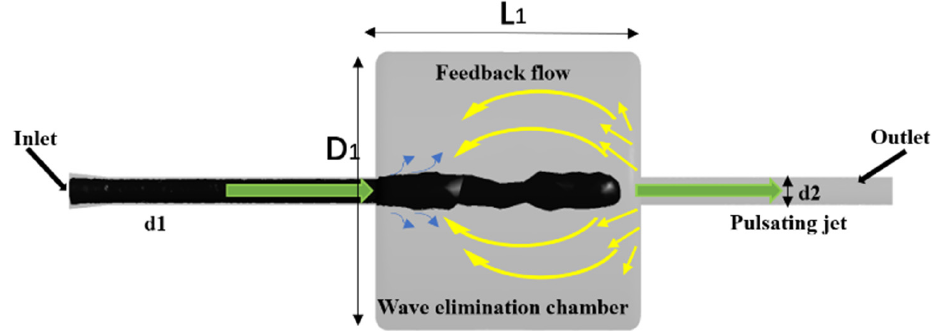
Figure 2. Schematic diagram of a traditional wave-elimination